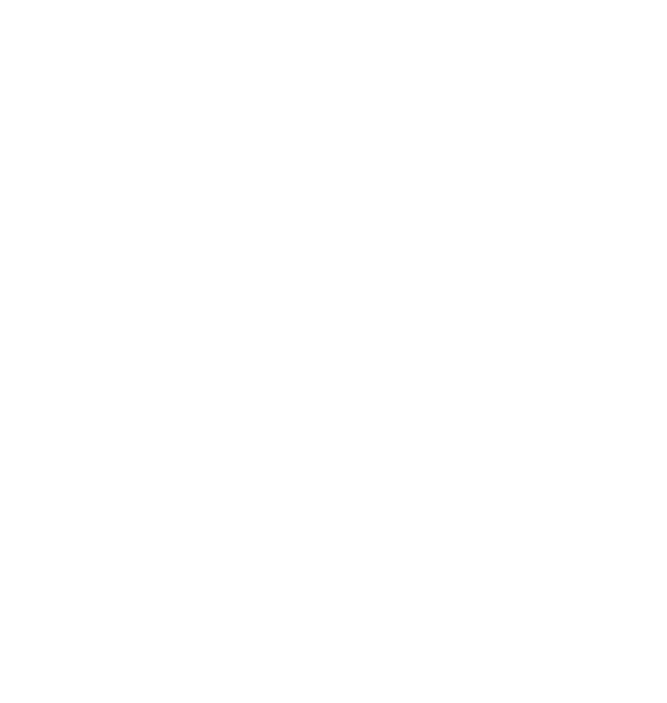
TGF-β regulates motility in LM3 cells. (A) LM3 cells treated with 2 ng/ml TGF-β1 for 16 h, by the wound-healing assay. Cells were also incubated with the kinase inhibitors SB202190 (10 μM) or U0126 (5 μM). Microphotographs of the same wound area were taken at the time of wounding and 16 h thereafter. Experiments were performed in triplicates and repeated at least twice. Representative phase-contrast images at ×40 magnification are shown. (B) Evaluation of cell migration. Data are expressed in arbitrary units (AU), and represent the mean ± SD of triplicates. (*p<0.05 vs. untreated cells, #p<0.05 vs. TGF-β-treated LM3 cells).